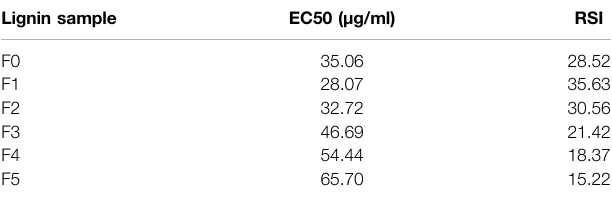
TABLE 3 | The free radical scavenging index (RSI) of the lignin samples.